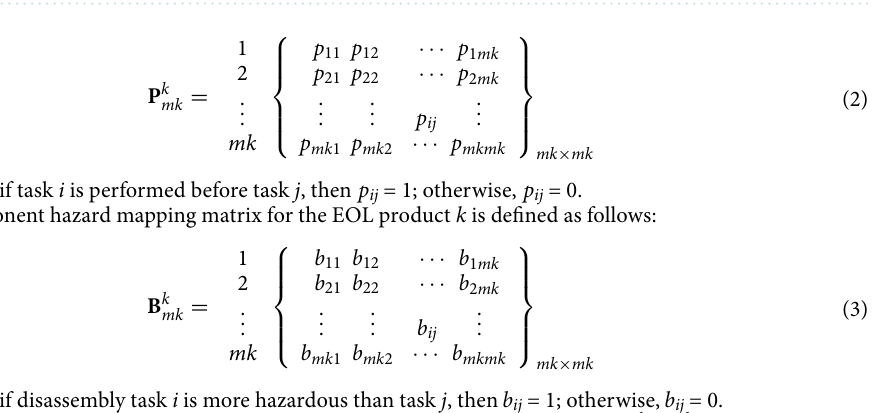
Figure 2. Parallel mixed-flow disassembly task allocation